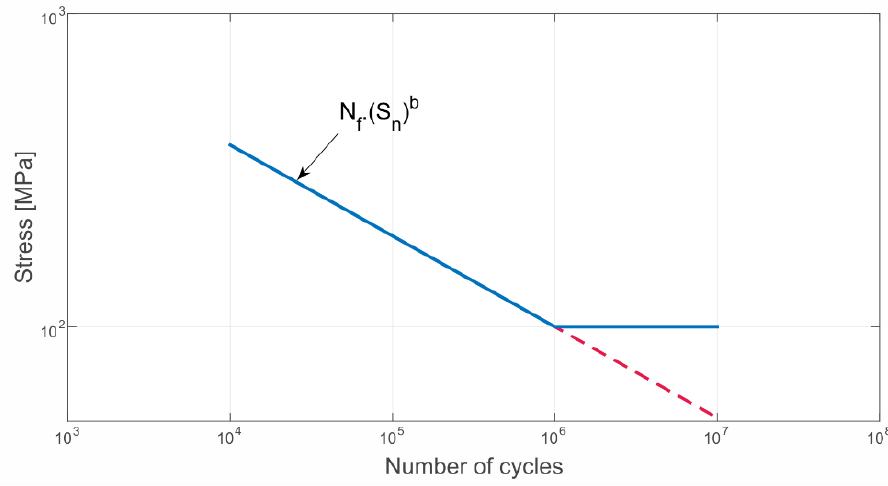
Figure 8. Idealized S-N curve defined using Basquin’s equation. Table 1. Mechanical properties and material constants of the material.